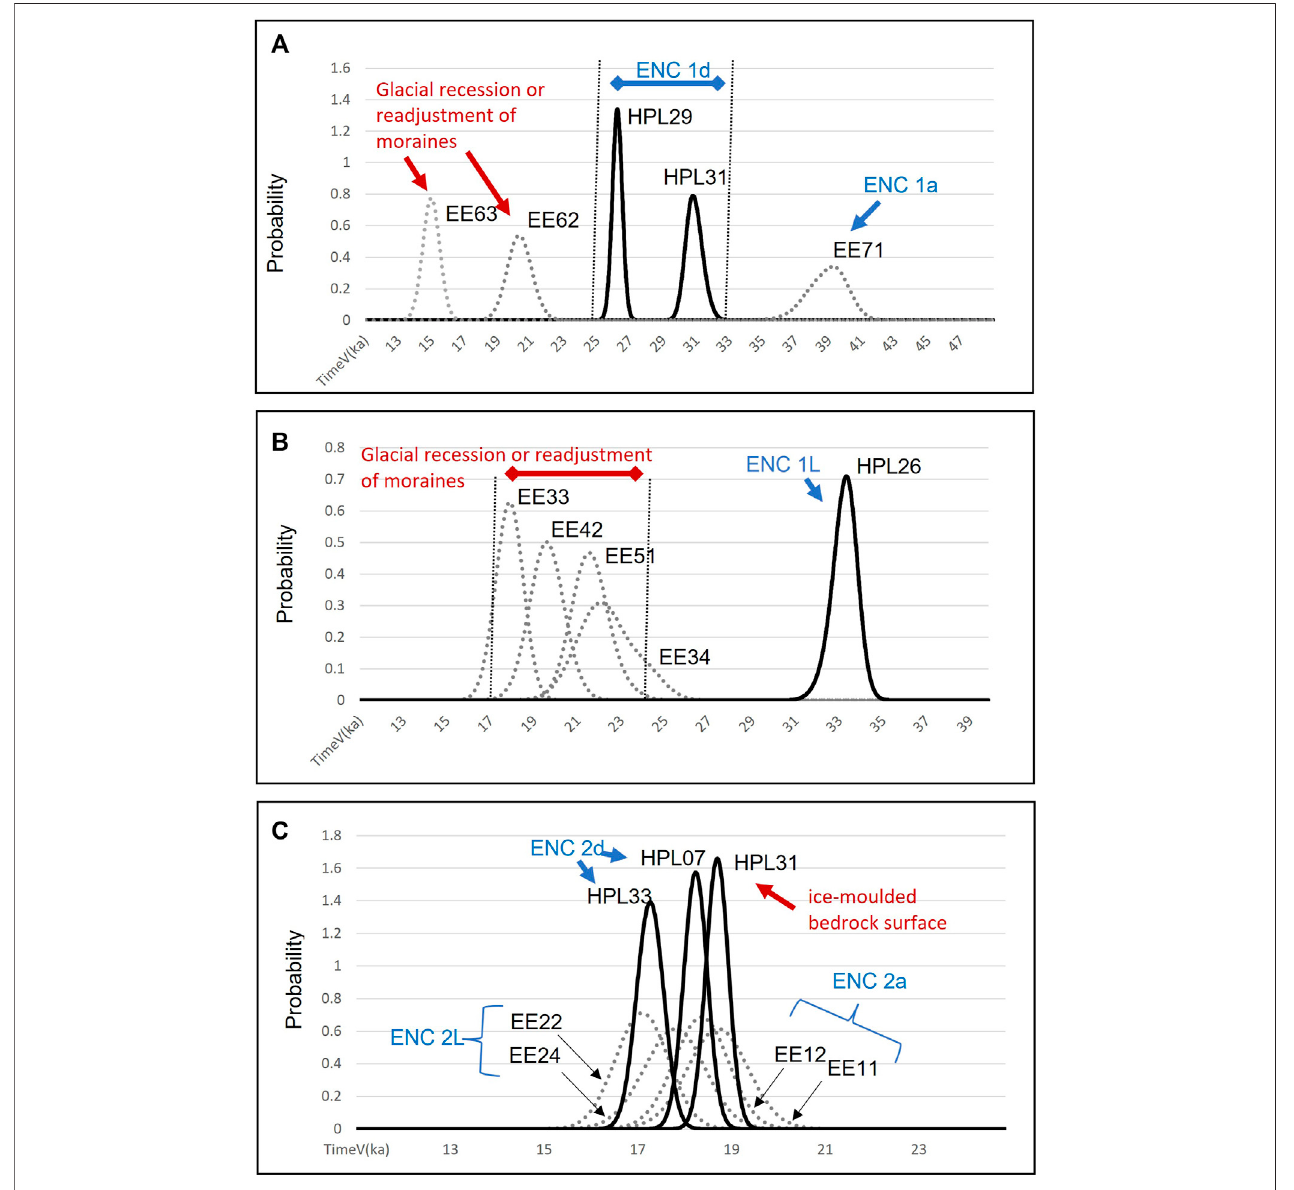
FIGURE3| Probabilitydensityfunctioncurvescalculatedfromtheexposure 10 Beages.Ageofsamplesobtainedinthisworkinblacksolidcurvesandrecalibrated from dataofZechet al.(2006) ingraysegmentedlines. (A) MorainesarcsofENC 1(25 – 40ka)andglacial recession orreadjustmentofmoraines. (B) Lateral morainesof ENC 1 (~33 ka) and glacial recession or readjustment of moraines (17 – 24 ka). (C) Moraine ridge and ice-molded bedrock surface of ENC2.